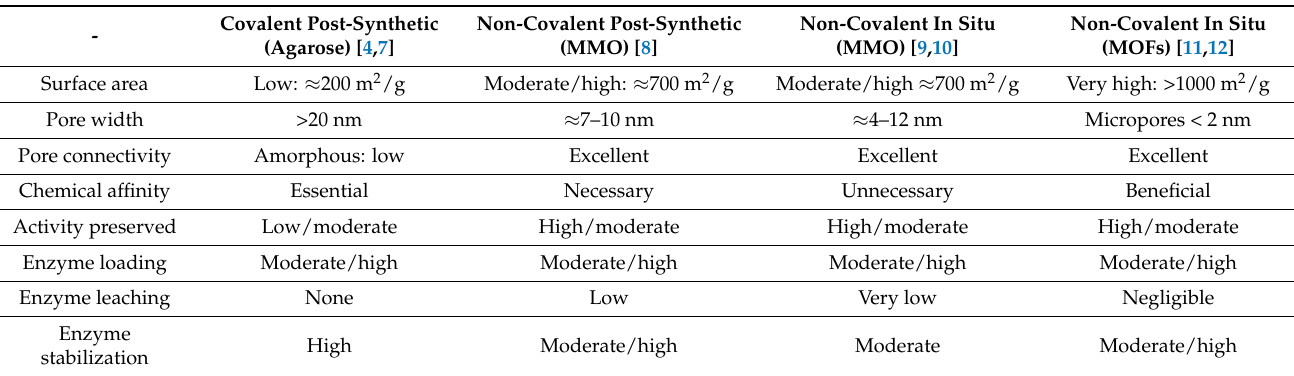
Table 1. Comparison of properties and performance of some selected immobilization strategies and porous supports of enzymes: covalent immobilization on amorphous agarose; non-covalent immobilization by post-synthetic or in situ addition to siliceous mesoporous ordered materials (MMO), and in situ immobilization onto MOFs. Table entries are displayed according to the following color-coding: green for good, yellow for middle and red for